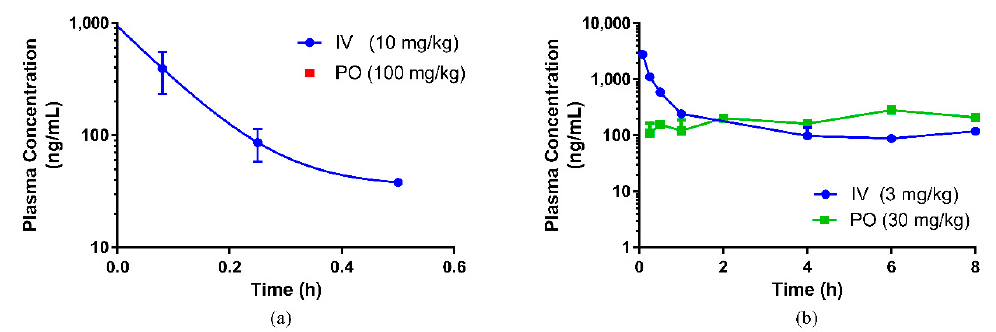
Figure 2. Pharmacokinetic profile of ( a ) standardized water extract (SWE) of E. longifolia and ( b ) eurycomanone compound, respectively, in rats. (IV = intravenous route, PO = oral route).